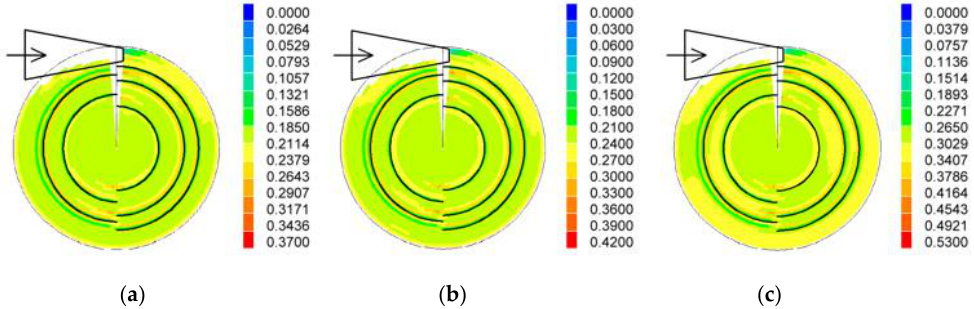
Figure 7. Particle distribution and volume in the two-phase flow in the cyclone at 9.3 m/s ( a ), 8.3 m/s ( b ), and 6.3 m/s ( c ) inlet velocities using the median-diameter (8.995 µ m) glass particulate matter at a 5 g/m 3 inlet concentration.